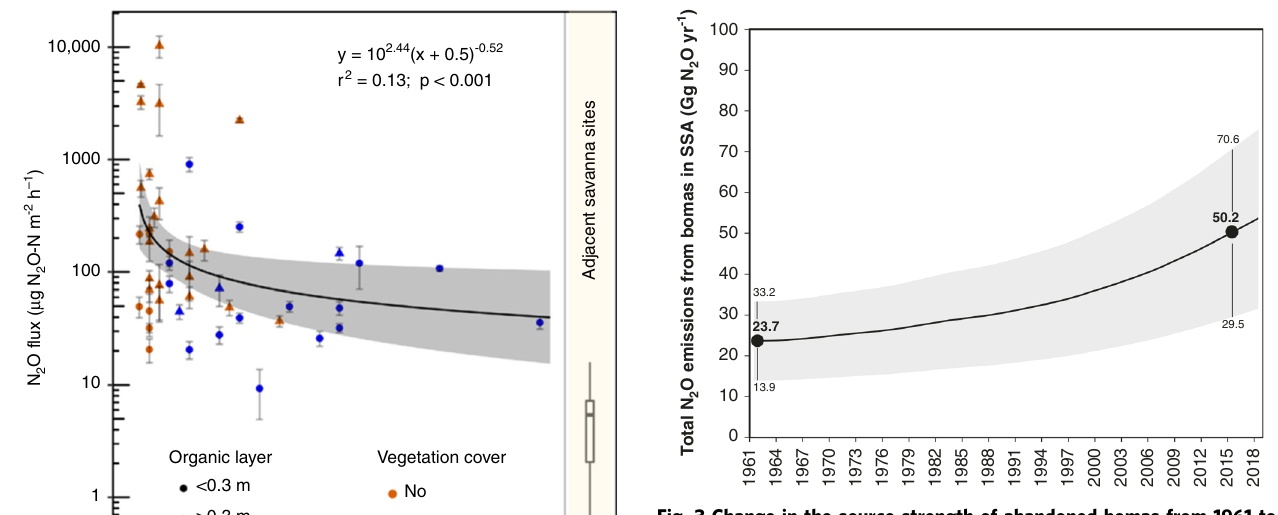
Fig. 2. We consider this to be a conservative estimate because we did not include the range of variation from diurnal measurements or pulse emissions of N 2 O following rainfall events. This calcu- lation resulted in a cumulative mean emission rate of 25 g N 2 O-N per m − 2 boma area over 40 years (95% con fi dence interval, CI: 13.3 – 48.1 g N 2 O-N m − 2 ) and a mean annual rate of 0.62 g N 2 O-